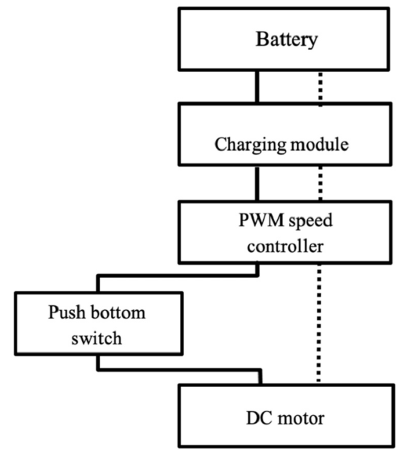
Figure 1. ( a ) The DPI add-on device model design and ( b ) the assemble of DPI and the add-on device.